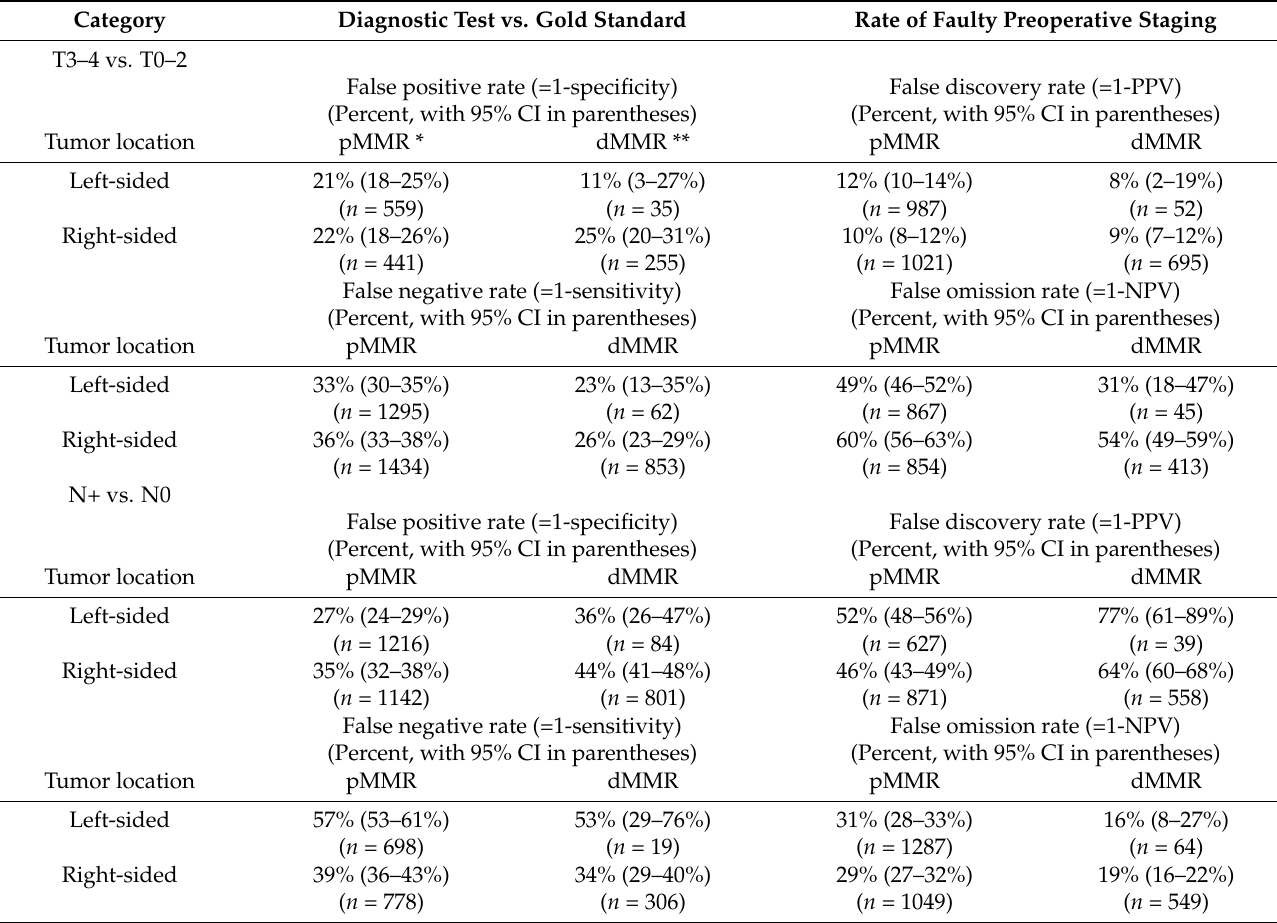
Table 4. Crosstabulations of false positive rates, false negative rates, false discovery rates and false omission rates against tumor sidedness and mismatch repair